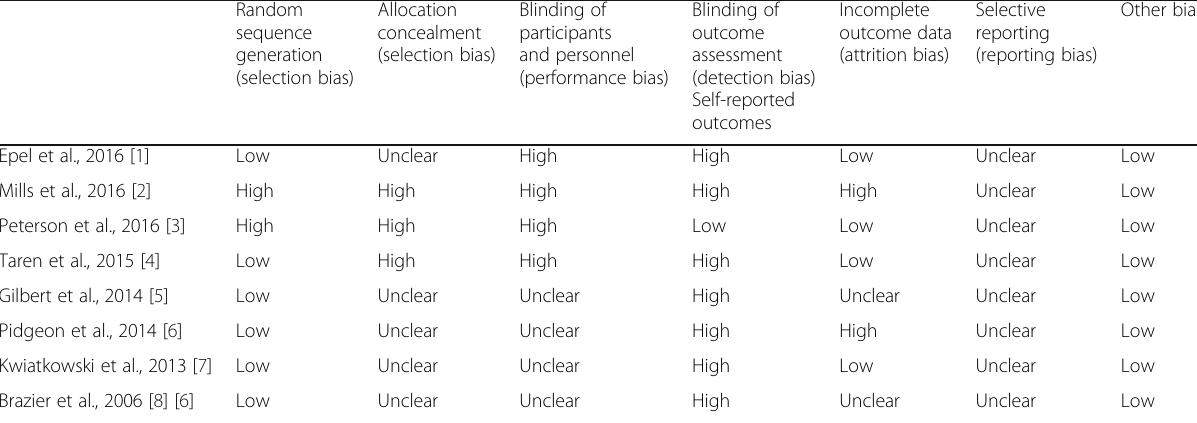
Table 4 Risk of bias summary for Randomised Controlled Trial Studies Random sequence